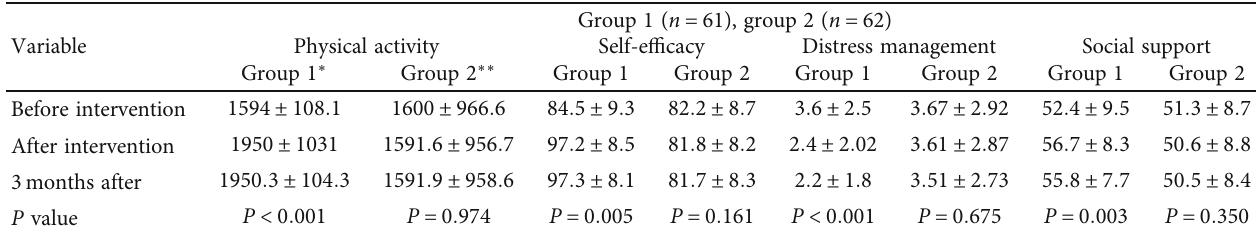
Table 3: Comparison of mean score of physical activity, self-e ffi cacy, distress management, and social support in both groups before and after the